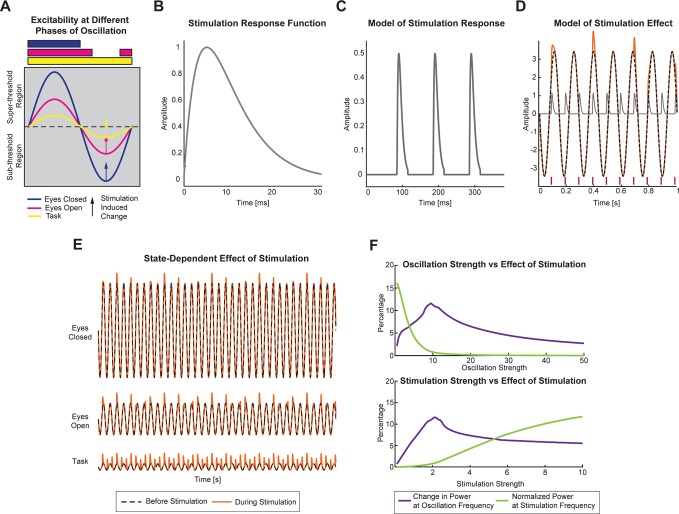
Simple Static Model Explains State-Dependence.(A) The endogenous oscillation is denoted as a pure sine wave, and the amplitude of the sine wave represents the strength of oscillation in the three states studied here. Dotted line denotes the threshold above which stimulation produces a change (denoted by arrow). When the change produced by stimulation is below the threshold, no change in the oscillation is observed. However, when the threshold is crossed, stimulation produces a response that decays with time. The bands denote the phases of the oscillation at which stimulation produces a change in the oscillation. For stronger oscillations (eyes-closed), the phases at which stimulation produces change are minimal. For very weak oscillations (task-engaged), stimulation produces change at all phases. (B) The function used to model the stimulation response. The stimulation response is modeled as the linear convolution between the stimulation pulse and this response function. (C) Convolution between stimulation pulses and stimulation response function. (D) Example traces illustrating the model behavior. The red lines at the bottom denote the timing of the stimulation pulses. The gray line denotes the stimulation response that is added to the oscillation waveform (black dashed line) to produce the stimulation effect (orange solid line). (E) Example traces produced using the model described in (A). In the eyes-closed state, stimulation-induced changes are minimal. In the eyes-open state, the stimulation-induced change is still constrained by the endogenous frequency. In the task-engaged state, stimulation produces change at all phases resulting in entrainment. Black dashed line represents the endogenous oscillation. Red solid line represents the waveform resulting from the addition of the stimulation waveform to the endogenous oscillation. (F) Top: Effect of varying endogenous oscillation strength. The change in power at the endogenous frequency increases until a certain limit and then decreases when the strength of oscillation relative to stimulation strength is high (violet line). The power at stimulation frequency (green line) decreases with increasing oscillation strength as stimulation effect is observed in a restricted range of phases. Bottom: Effect of varying stimulation strength for a given oscillation strength. As stimulation strength increases, the power at oscillation frequency increases until the strength relative to oscillation strength is high enough to cause increase in power at stimulation frequency. Beyond this, the increase in power at oscillation frequency is minimal, and power at stimulation frequency increases monotonically. The data shown in this figure are available online: http://dx.doi.org/10.5281/zenodo.45811